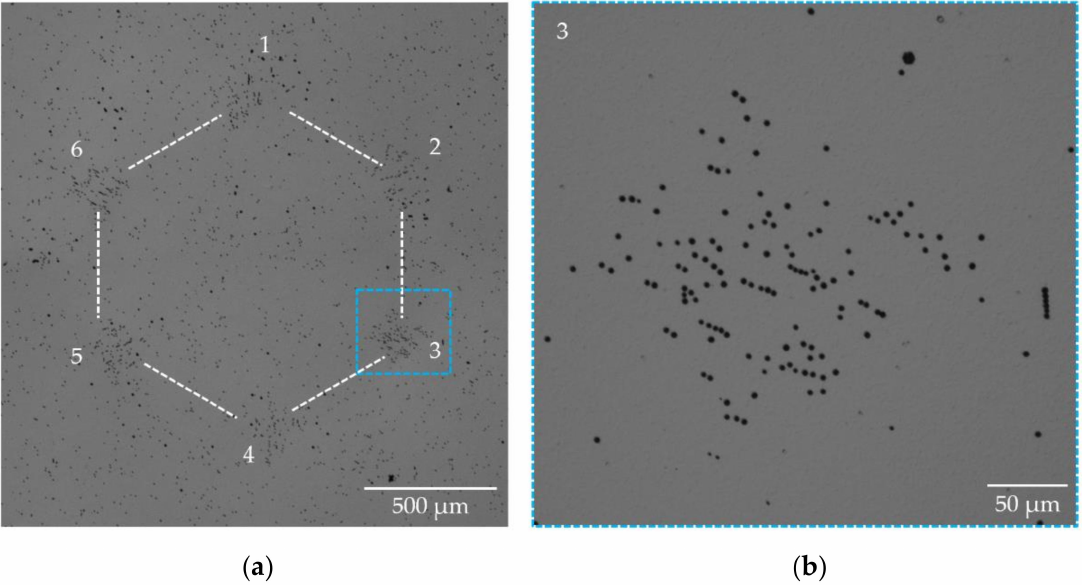
Figure 8. ( a ) DIC optical image of the etched HCD shown in Figure 5h. TEDs of each DB in six corners of the honeycomb cluster are spread over an area with a “diameter” of ~250 µ m, as shown for DB-3 in the enlarged image ( b